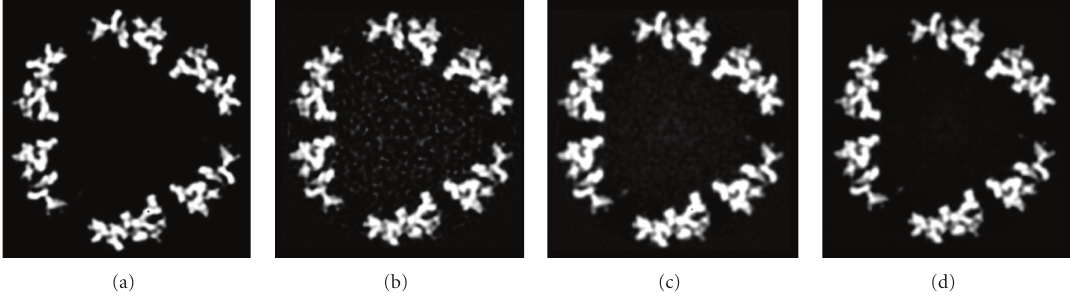
Figure 4: Maps of two-dimensional sections perpendicular to Z axis with Z = 0 of the DegP 24 model and reconstruction results viewing along the 3-fold axis by the OSAF method: (a) the standard model, (b) the reconstructed results with S/N = 0 . 1, (c) S/N = 0 . 5, (d) S/N = 0 . 8.